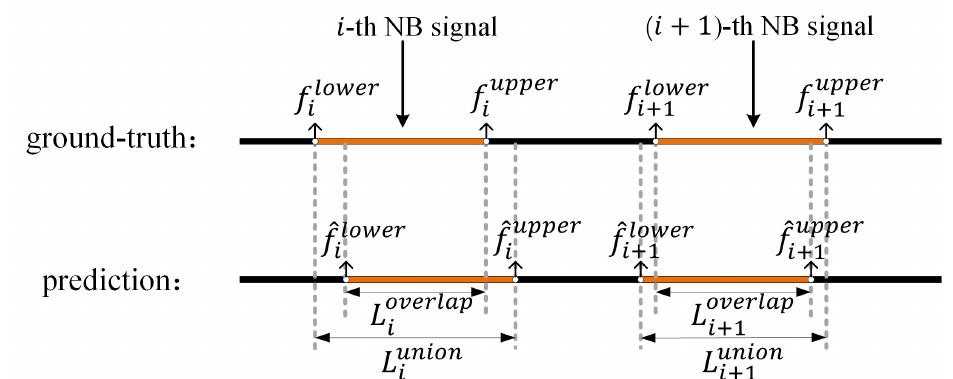
Figure 7. The length of overlap and union between the true signal spectrum position and estimated signal spectrum